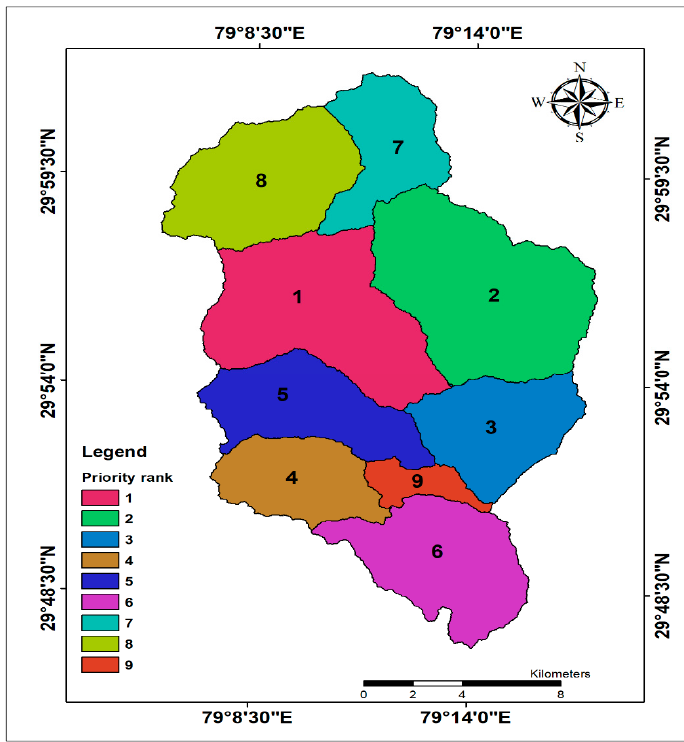
Figure 5. Map of final priority rank of nine sub-watersheds of BW.